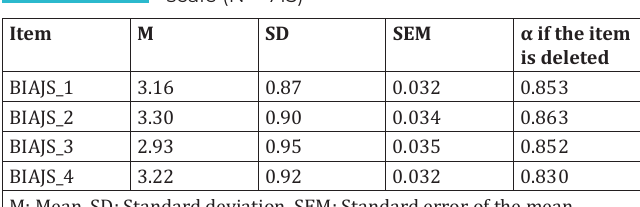
Preliminary descriptive statistics for the BIAJS scale (N =